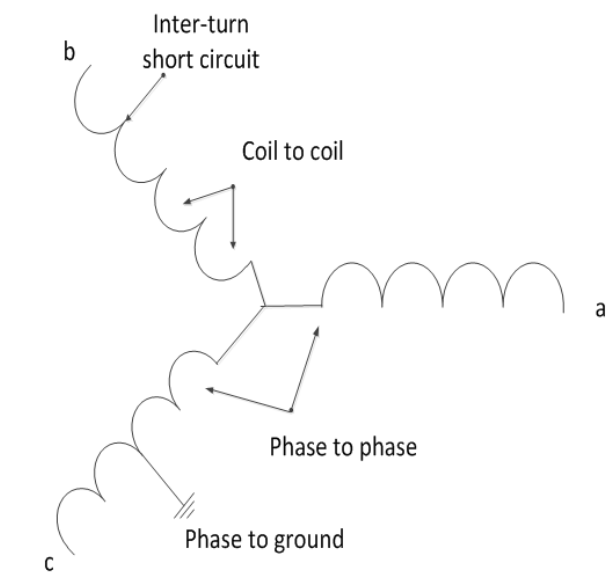
Figure 4. Failure modes of stator